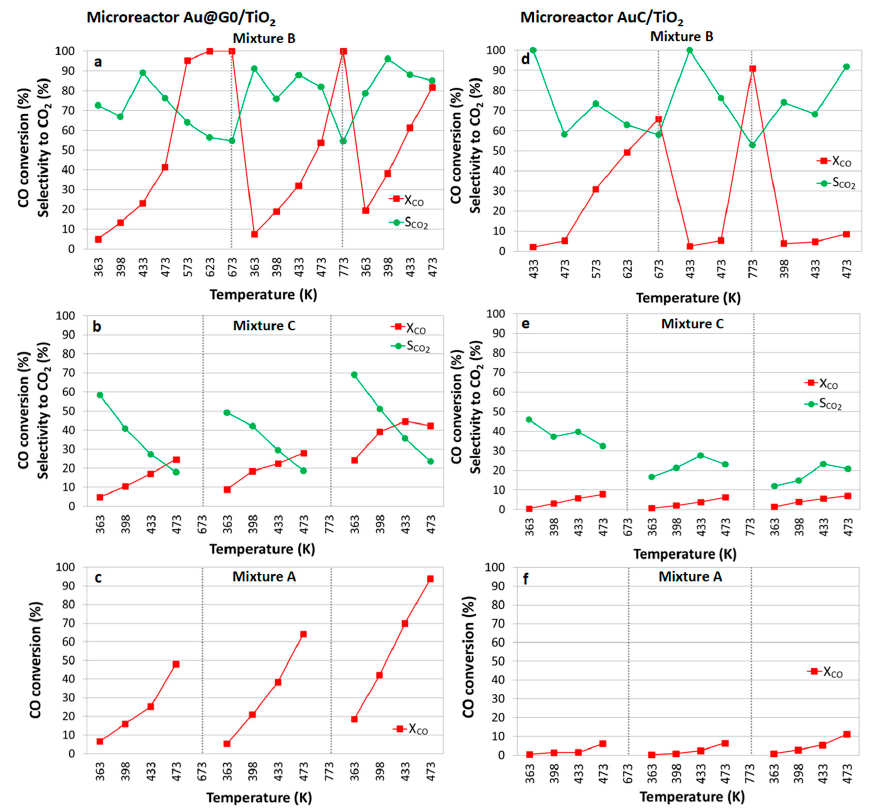
Figure 8. CO conversion and CO 2 selectivity as a function of temperature for the three